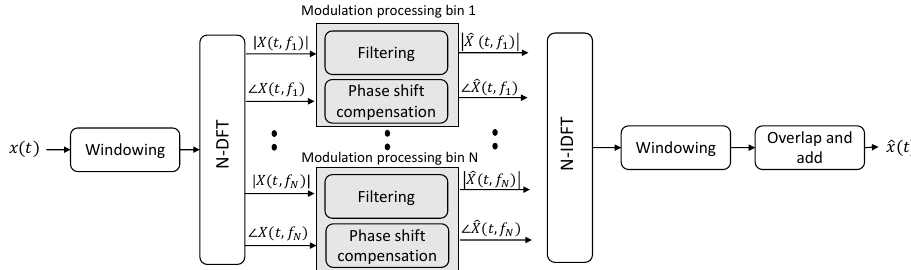
Figure 3. Signal processing steps for signal enhancement via modulation spectrum